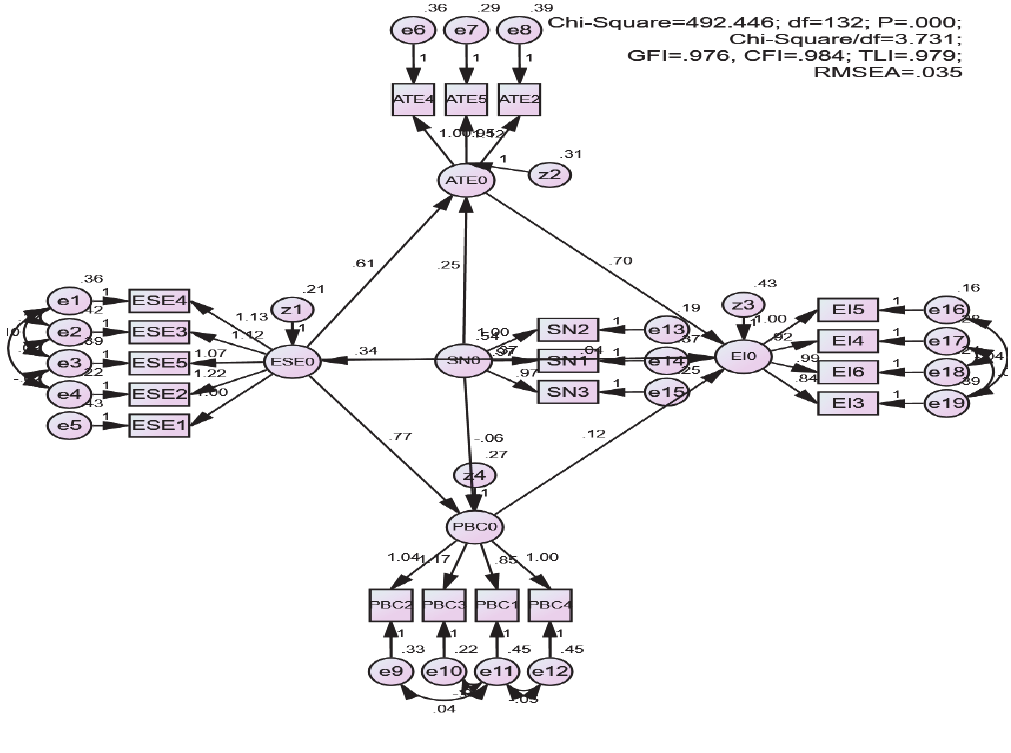
Fig. 3. The results of structural analyses (unstandardized estimates) The overall fit statistics the model without the control variables illustrated an acceptable level of fit: χ 2 (134) =492.446, p = 0.000. CMIN/df = 3.731 < 0.5, CFI = 0.984, GFI = 0.976, TLI = 0.979 > 0.9, RMSEA